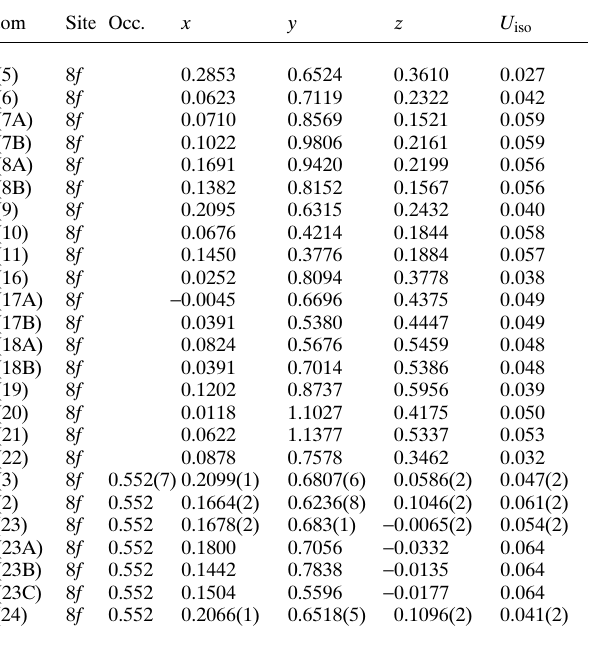
Table 2. Atomic coordinates and displacement parameters (in Å 2 ) .